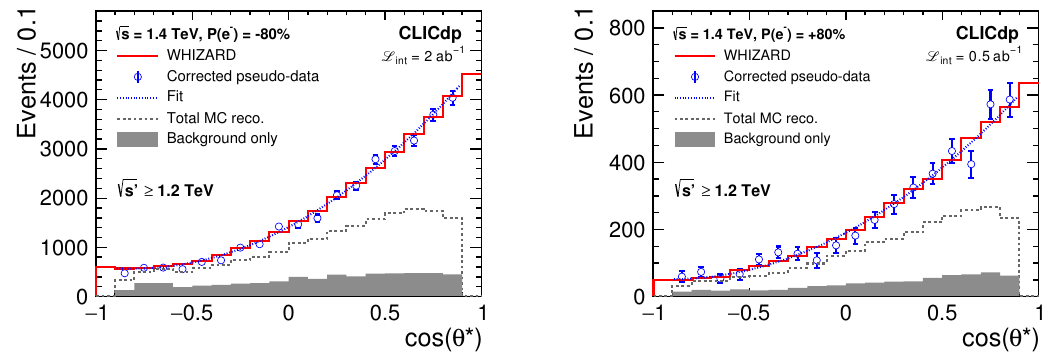
Figure 21. Top-quark polar angle distributions from the analysis of boosted semi-leptonic tt events, at a nominal collision energy of 1.4 TeV for P (e (cid:0) ) = -80% (left) and P (e (cid:0) ) = +80% (right), and an integrated luminosity of 2 : 0 ab (cid:0) 1 and 0 : 5 ab (cid:0) 1 , respectively. The dashed black curve shows the reconstructed total MC distribution, while the grey area indicates the level of background only. The blue data points and dotted line represent one pseudo-experiment after subtraction of background and correction for (cid:12)nite selection e(cid:14)ciencies, and the corresponding (cid:12)t, respectively. The red solid line represents the simulated parton-level distribution.